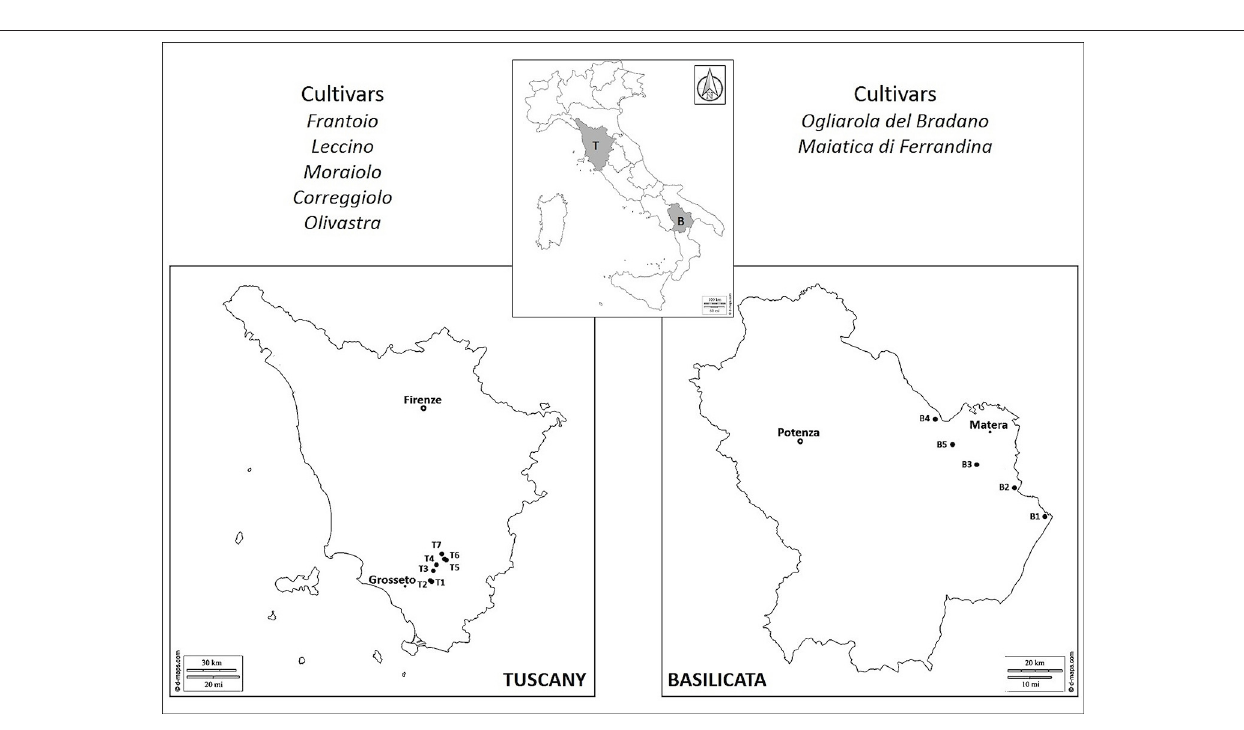
FIGURE 2 | Map of Italy showing the locations of the 12 olive groves studied in Basilicata (B, Southern Italy) and Tuscany (T, Central Italy). The cultivars of Olea europaea L. ssp. europaea cultivated in these olive groves are reported at the right (B) and left (T) of the map. The labels of the olive groves (B1–5, and T1–7) follows the list embedded in the Figure 2